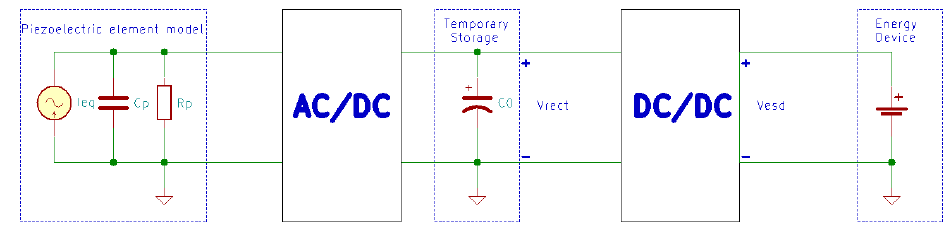
Figure 17. Generalized two-stage piezoelectric energy harvesting circuit.